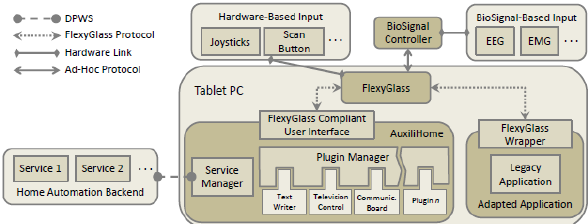
Figura 9. MWiMT’s architecture. Source: Caruso et al.